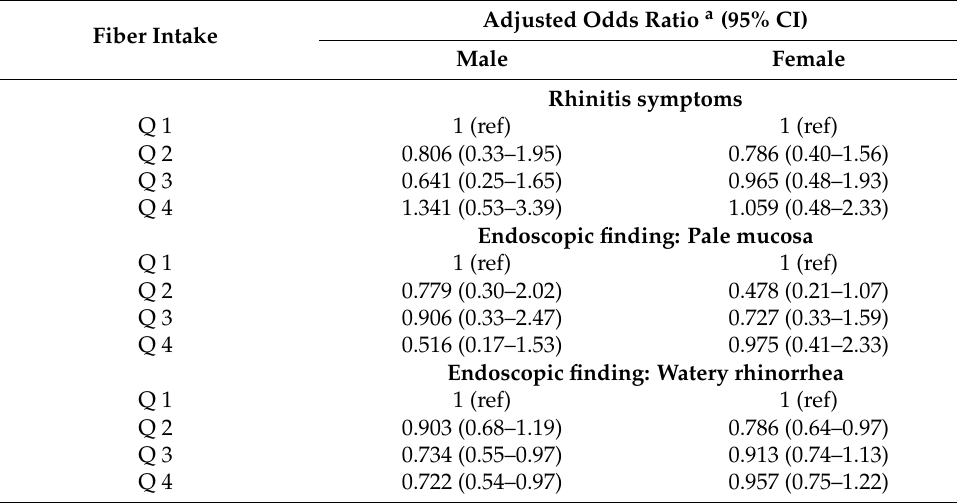
Table 5. Multivariate logistic regression analysis of the association between fiber intake and allergic rhinitis-related